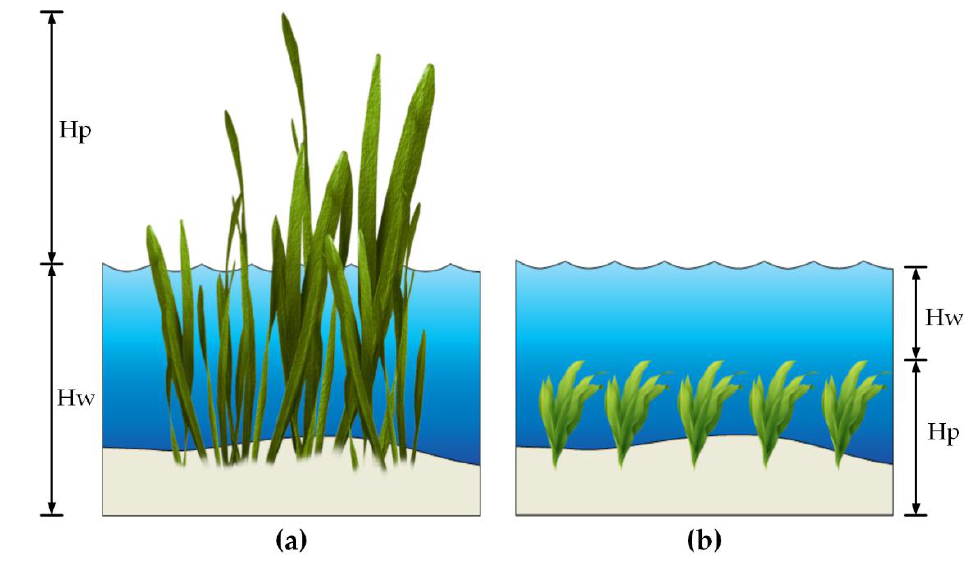
Figure 1. The Schematic of vertical structures for emergent vegetation and submerged vegetation. ( a ) Emergent vegetation; ( b ) Submerged vegetation.